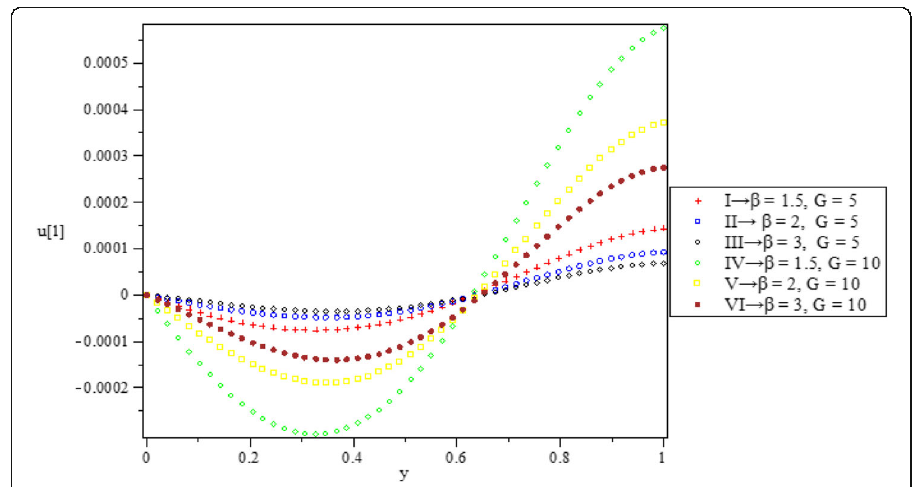
Fig. 17 First-order velocity (u[1] profile, r = − 1, ϵ = 0.25, P = 0.71 α = 5, and λ = 0.01)